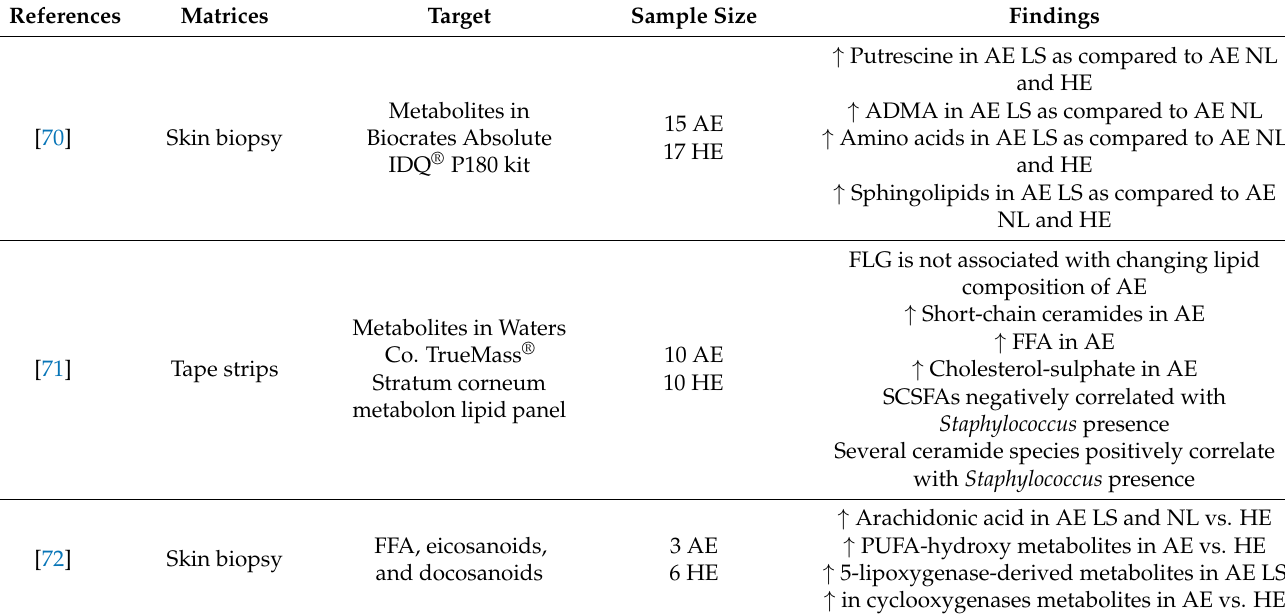
Table 1. Summary of AE metabolomics studies with skin samples. Abbreviations: AE (atopic eczema participants), LS (lesional skin), NL (non-lesional skin), HE (healthy participants), P (psoriasis participants), SCSFAs (short-chain saturated fatty acids), LCSFAs (long-chain saturated fatty acids), FA (fatty acids), ADMA (asymmetric dimethyl-arginine), C (chain length). Co. (cooperation), FLG (filaggrin), FFA (free fatty acids), UT (untargeted), and IV (ichthyosis vulgaris). Symbols: ↑ (increase) and ↓